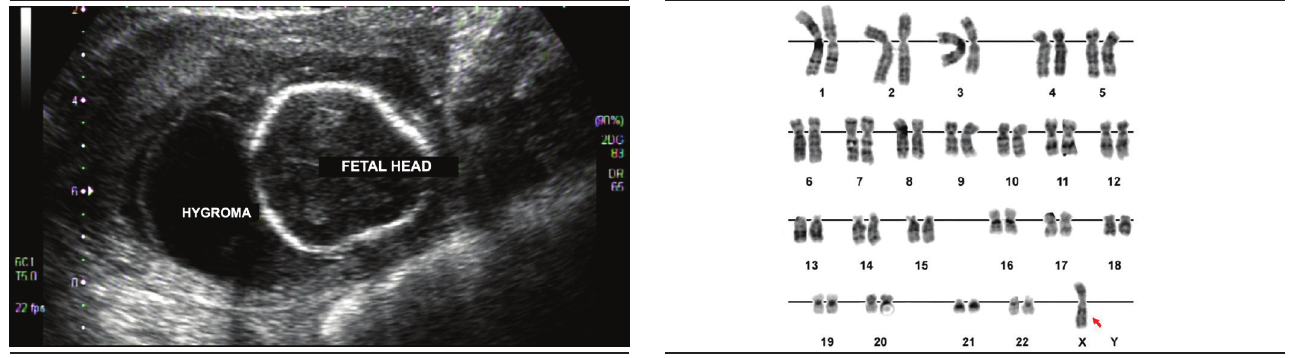
figurE 2 − Fetal karyotyping performed from cystic hygroma cells revealing a X-monosomy (45,X), consistent with Turner